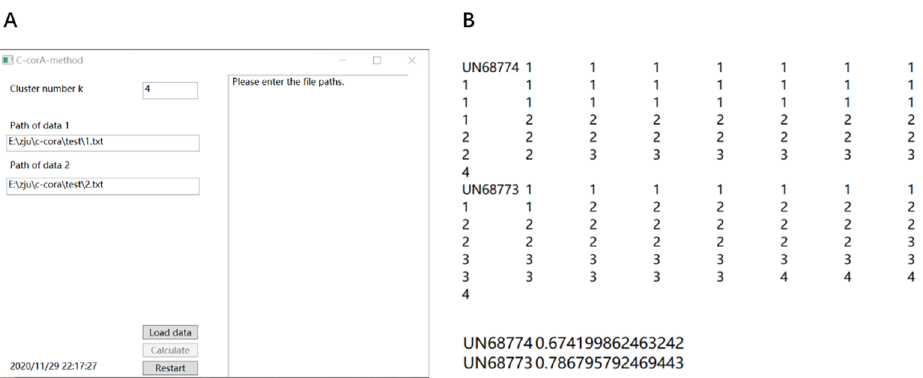
Figure 2. ( A ) The appearance of the C-CoA application written using C # WPF. ( B ) An example of an output file.